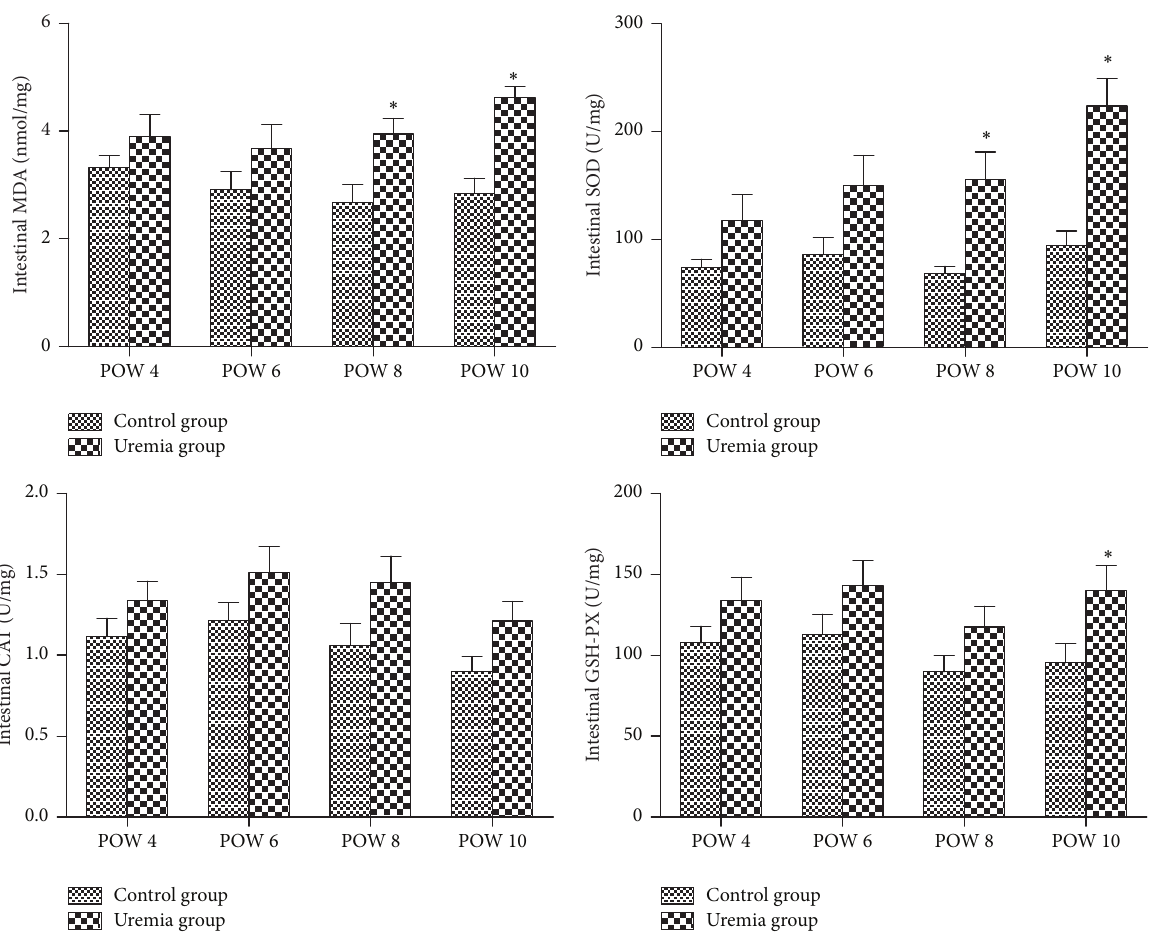
Figure 7: The intestinal levels of MDA, SOD, CAT, and GSH-PX in each group. POW: postoperative week. Data are expressed as mean ± SD. ∗ 𝑃 < 0.05 , versus control group at the same time point.